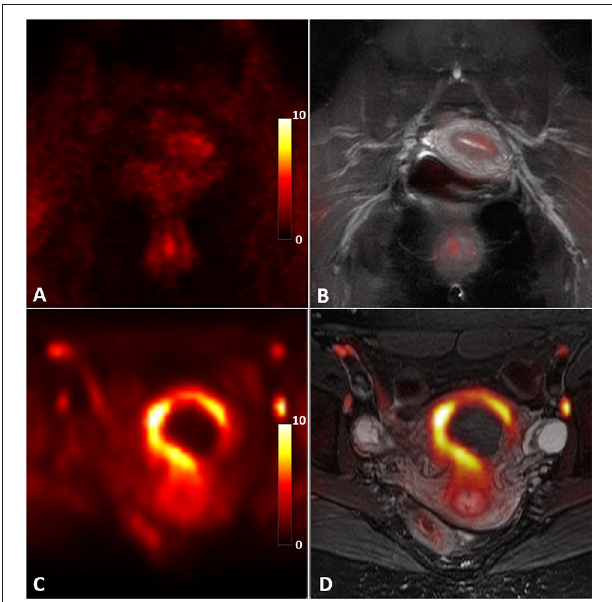
FIGURE 2 | Abnormal S1R tracer uptake of the uterus in Patient 1 compared to an asymptomatic control. S1R PET (A) and PET/MR co-registered (B) images in an asymptomatic control present diffuse, low uptake compared to the S1R PET (C) and PET/MR co-registered (D) images of the patient. Note that the fibroid does not take up the radioligand. The PET images were plotted in the unit of standardized uptake value (SUV).